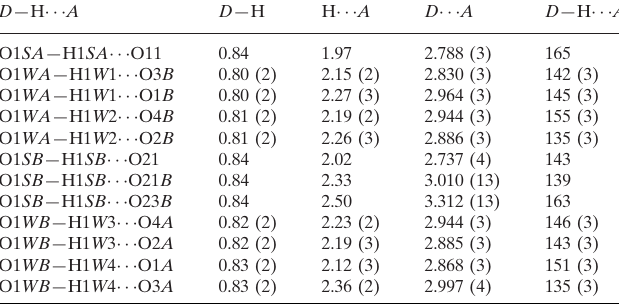
Data collection Oxford Diffraction Xcalibur diffractometer with a Ruby (Gemini Mo) detector Absorption correction: multi-scan ( CrysAlis RED ; Oxford